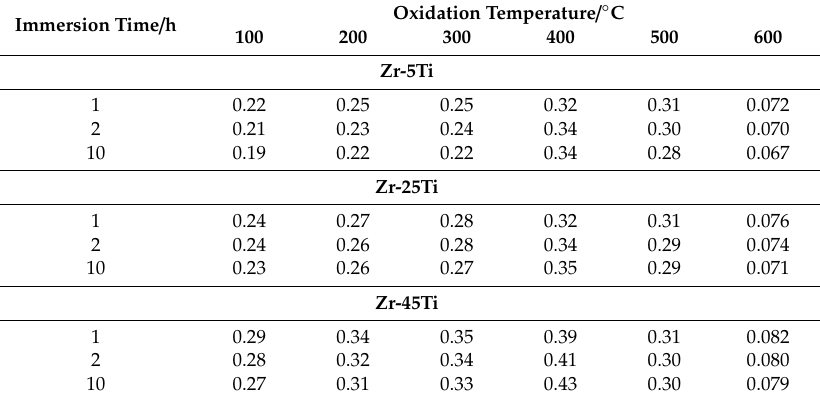
Table 3. Values of the polarization resistance (in M Ω · cm 2 ) as a function of immersion time of thermally oxidized Zr-Ti alloys in phosphate bu ff ered saline solution acidified at pH = 4.1 ± 0.1